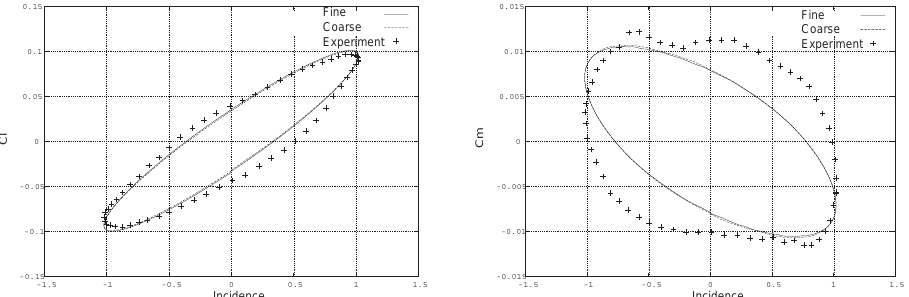
Fig. 2 Comparison of computed and experiment force and moment